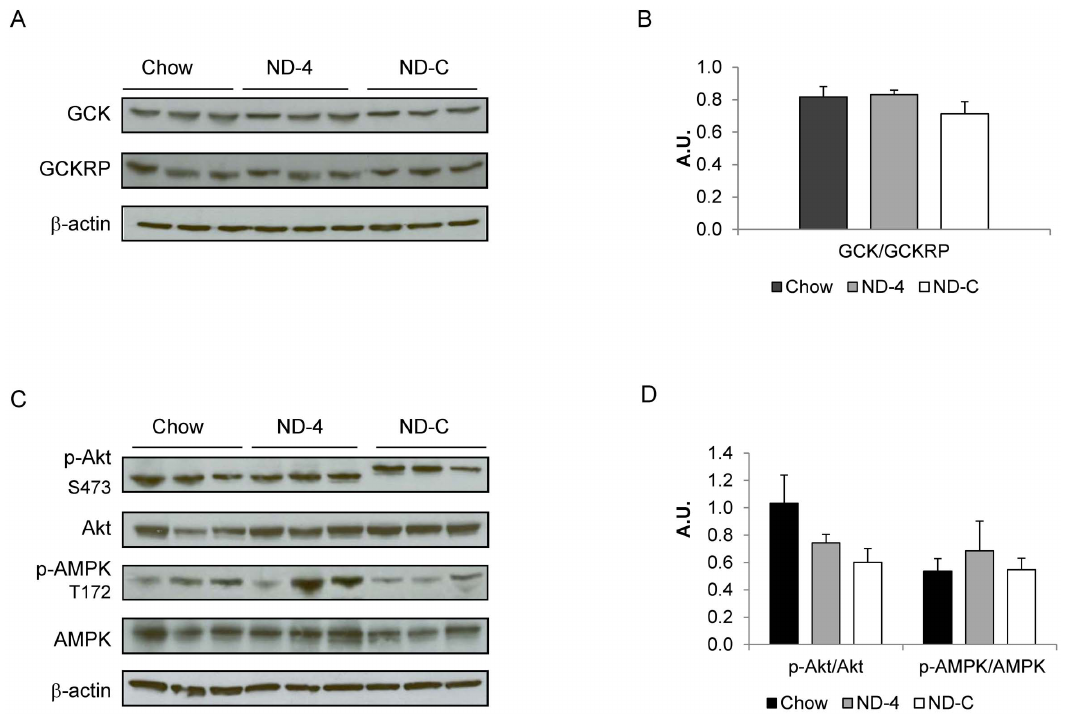
Figure 3. Protein expression and ratio of GCK and GCKRP (A, B) and activation of AMPK and Akt (C,D) in the liver from chronically catheterized conscious insulin treated depancreatized dogs that were either on a chow diet or fed isocaloric nutritional support as a constant infusion (ND-C) or once a day for 4 days (ND-4). Western blot images are representative of three experiments. Ratios are calculated as the average of phosphorylated protein divided by total amount of protein and represented in arbitrary units (A.U.).